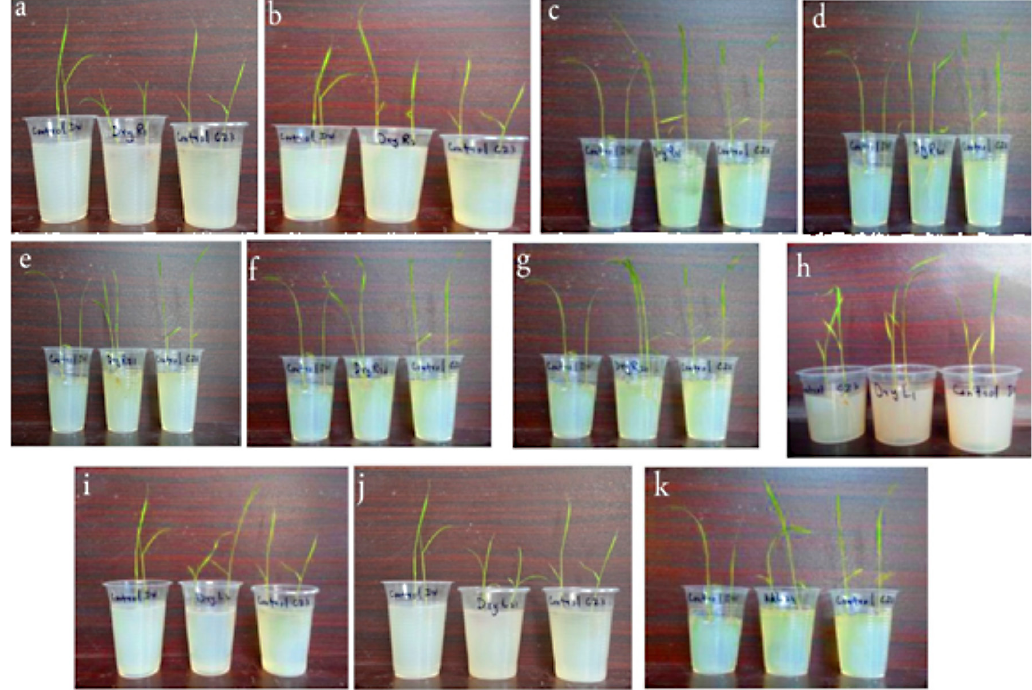
Fig. S2: Preliminary screening of fungal filtrates (100 μl) isolated from Dryopteris L. on rice seedlings at 2 leaves stage grown in 0.8% water-agar medium for 2 weeks at 25 °C. Reading taken after 1 week of culture filtrate application. Each set has 3 treatments. including Czapek control (right), distilled water control (left) and endophyte cultural filtrate